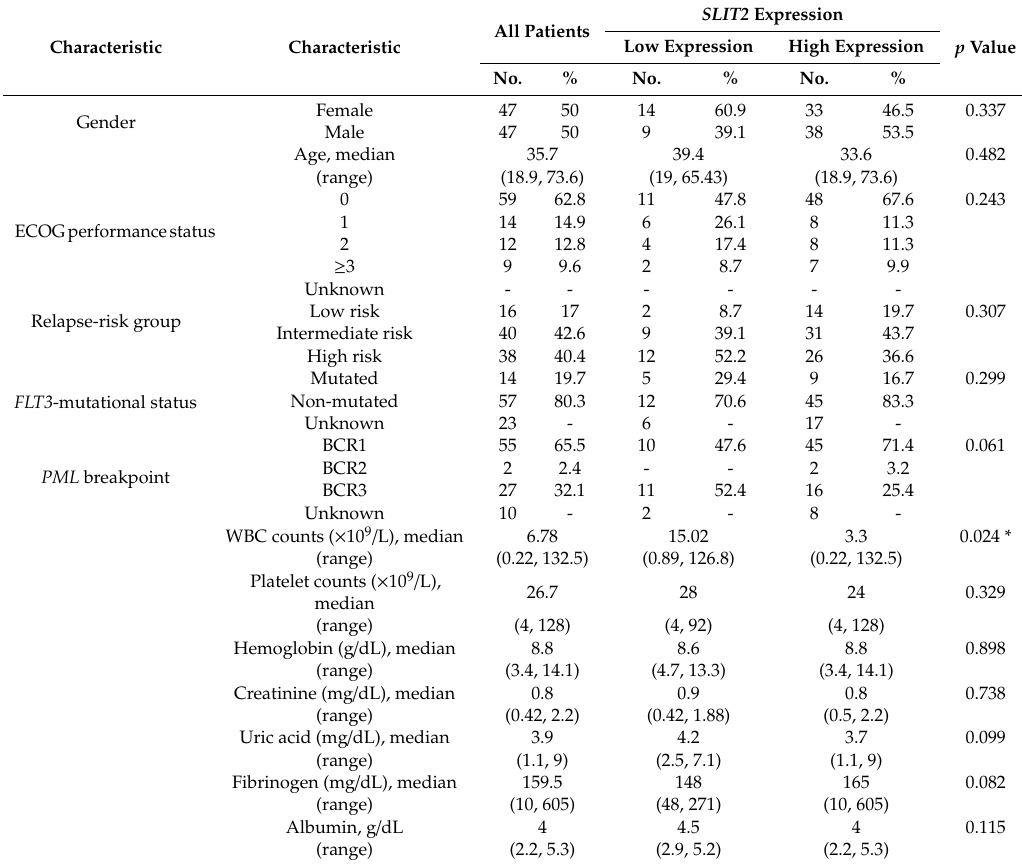
Table 1. Baseline